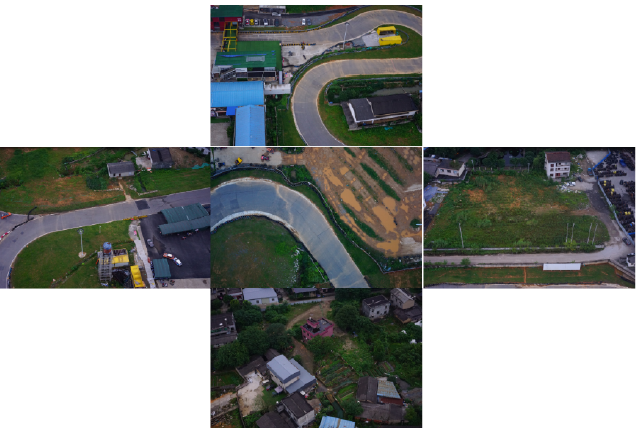
Figure 4. Sample images taken by PSDK 102S. Five images can be seen that were shot at the same time, so larger scenes can be covered